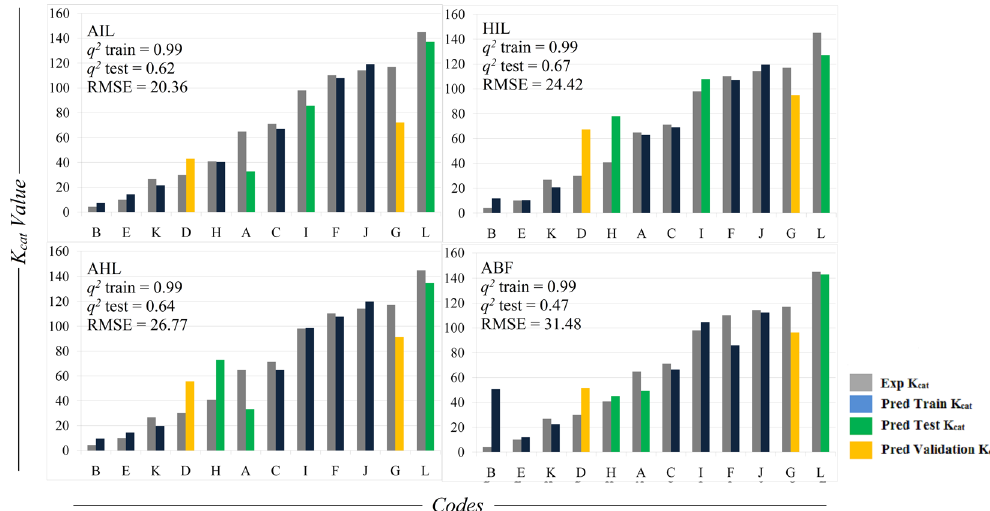
Figure 2. Analysis of the predicted activity values generated using PLS models derived from 1875 IEDs chosen based on the r value > 0.5. Graph shows the experimental vs. predicted activity values; training sets containing 7 codes (blue), test sets containing 3 codes (green); external validation set containing 2 codes (orange) and the respective experimental values (grey). The models sorted based on the least RMSD values of the training and the test set were used to predict the activity of the validation set (Table S5). The predictions on the validation set showed clear difference between the enzyme variants with high and low activity; however, the predicted K cat values were only a little closer to the experimental